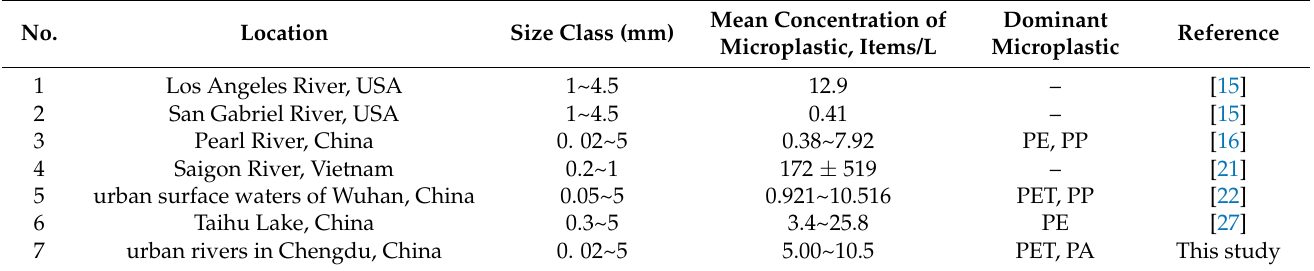
Table 1. Pollution abundance of microplastics in surface water in different